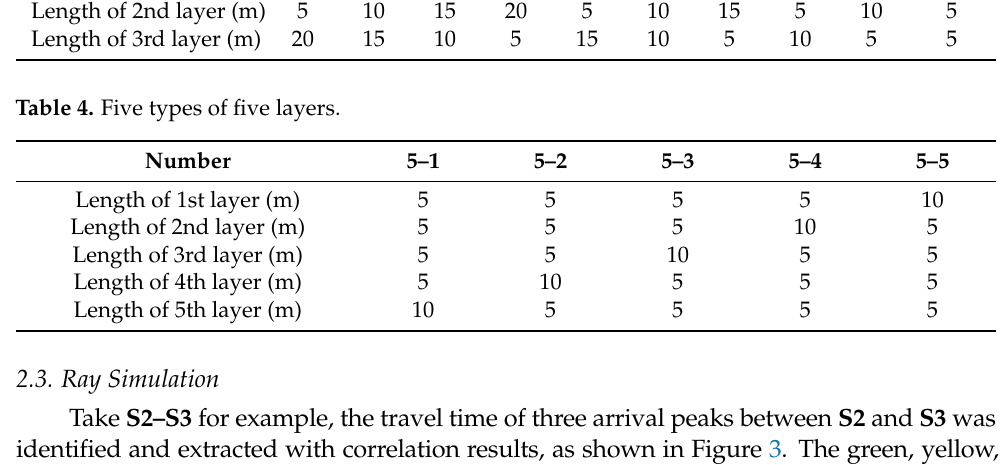
Figure 4. Ray simulations of different layer types in S1–S2 and S2–S3 . ( a ) Ray simulation of Number 2 ‐ 2. ( b ) Ray simula ‐ tion of Number 3 ‐ 7. ( c ) Ray simulation of Number 5 ‐ 2. ( d ) Temperature profiling. Three typical ray simulation comparisons in S1–S2 and S2–S3 are shown in Figure 4. The temperature profiling (d) measured by the TD array shows that temperature sud ‐ denly changes by about 10 °C as the depth increases, i.e., closer to the bottom. Therefore, the maximum depth of the layer line was set at 25 m. The main difference between differ ‐ ent layer methods is the acoustic ray simulation process. The multi ‐ path resolution results in different layers are same, but the final inversion result will have a big difference. Table 5 shows that the layer length and reference travel time of each ray in the two layers, three layers, and five layers of S2–S3 correspond to Figures 3 and 4, respectively. Table 5. Ray length and reference travel time (three rays and five layers). S1–S2